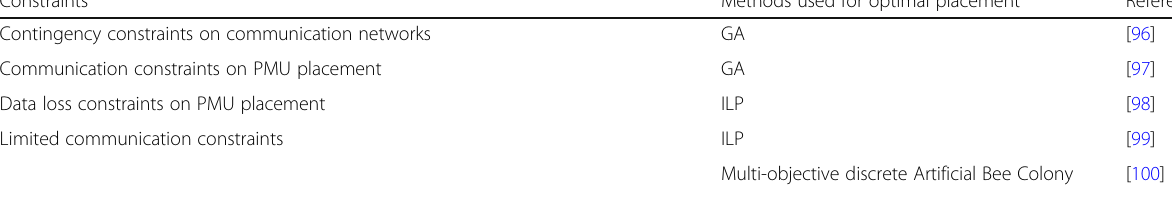
Table 7 Wide Area Damping Controllers Constraints Methods used for optimal